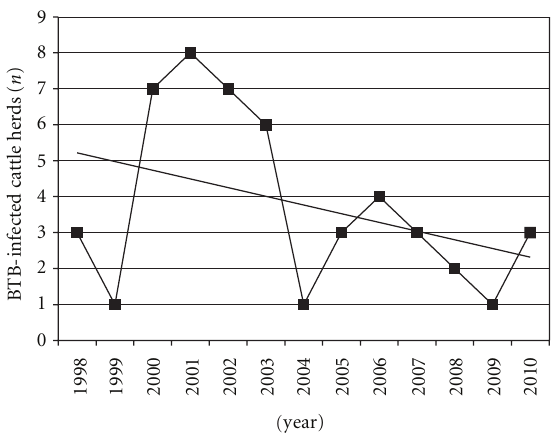
Figure 2: Annual incidence count of BTB cattle herds in Michigan (with linear trend line).